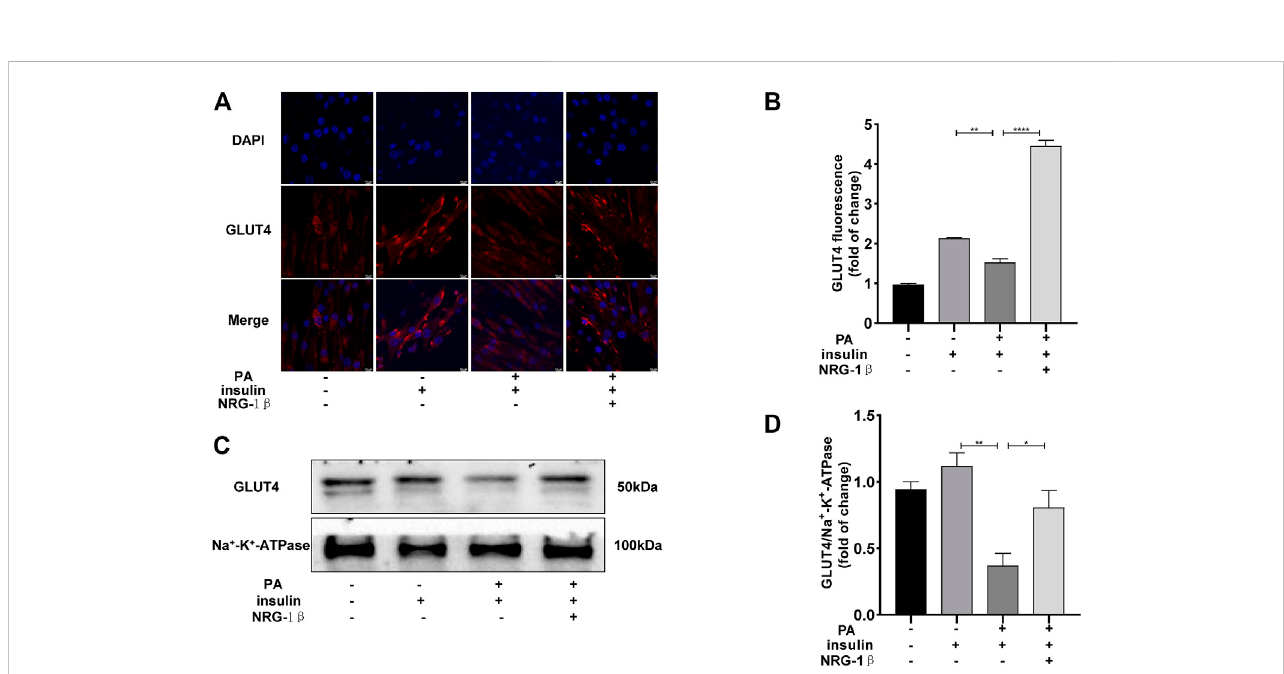
FIGURE 2 NRG-1 β promoted the translocation of GLUT4 in PA-treated C2C12 myotubes. Effects of NRG-1 β on GLUT4 translocation in PA-treated (plus insulin) C2C12 myotubes, GLUT4 was detected by using a fl uorescent anti-GLUT4 antibody (A,B) (Scale bar: 10 μ m) and Western blotting (C,D) . The data are presented as the mean ± SEM. * p < .05; ** p < .01; **** p <